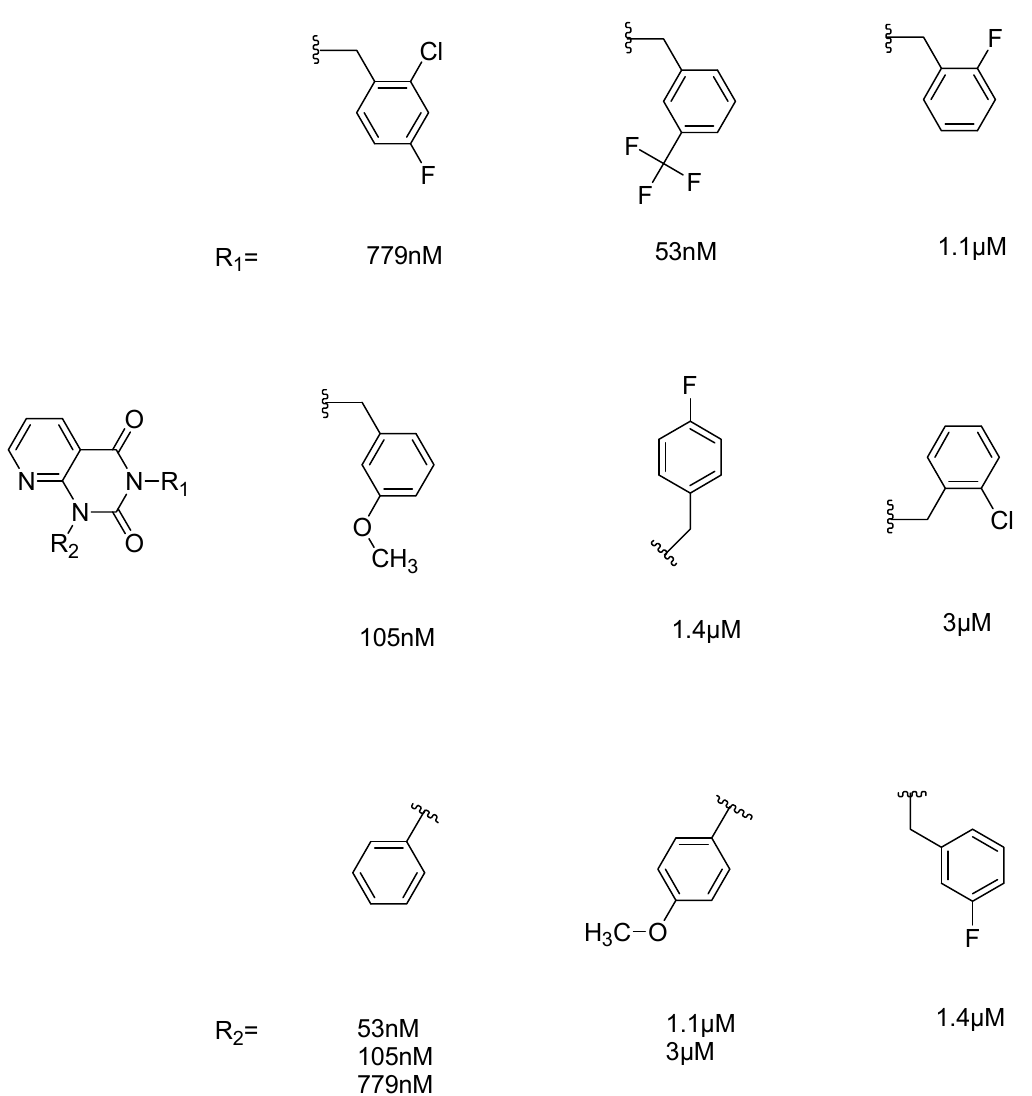
Figure 16. Preliminary structure-activity relationships of the most common chemotype of the 2nd round